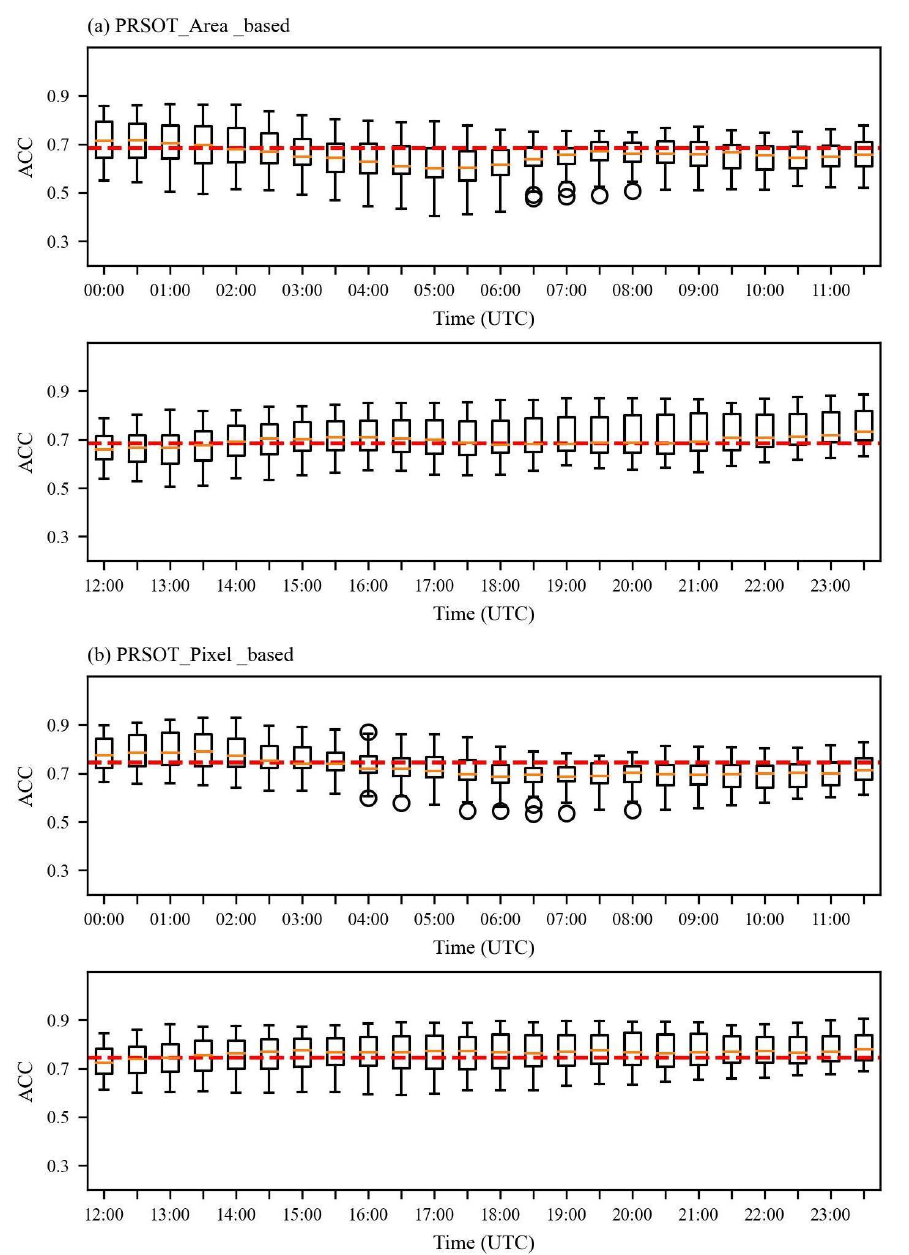
Figure 11. The diurnal variation of ACC for the precipitation grades’ estimation in testing dataset during August 2018. The red dotted line represents the average ACC, 0.49 for PRSOT_Area_based model ( a ) and 0.69 for PRSOT_Pixel_based model ( b ). Box diagrams indicate the 25th, 50th, and 75th percentiles, whereas the periphery of the box extends to 1.5-times the quartile deviation (25th–75th percentile). Outliers are indicated by black